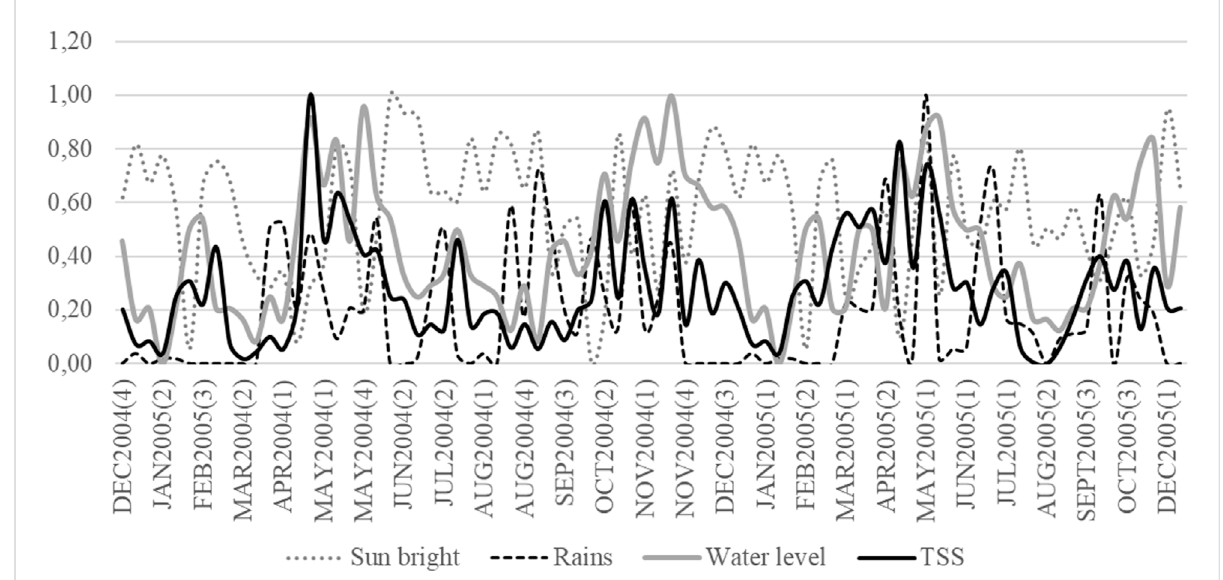
FIGURE 4 Weekly changes in Sun bright, rains, water level, and Total Suspended Solids in the Magdalena River in front of Puerto Berrio city between January 2004 and December 2005. Variables values are movil average for four periods (weeks) and each one was standardized to 0 – 1 values to let the graphic comparisons. In parenthesis, number of the week in the